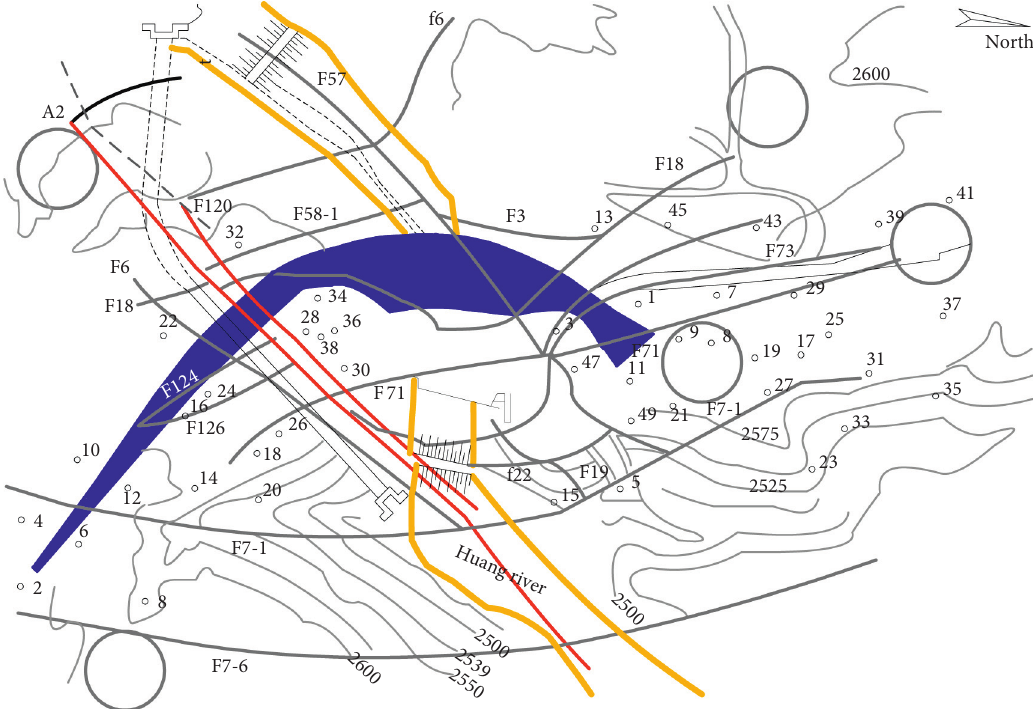
Figure 10: Distribution of main faults and layout of the groundwater monitoring holes.